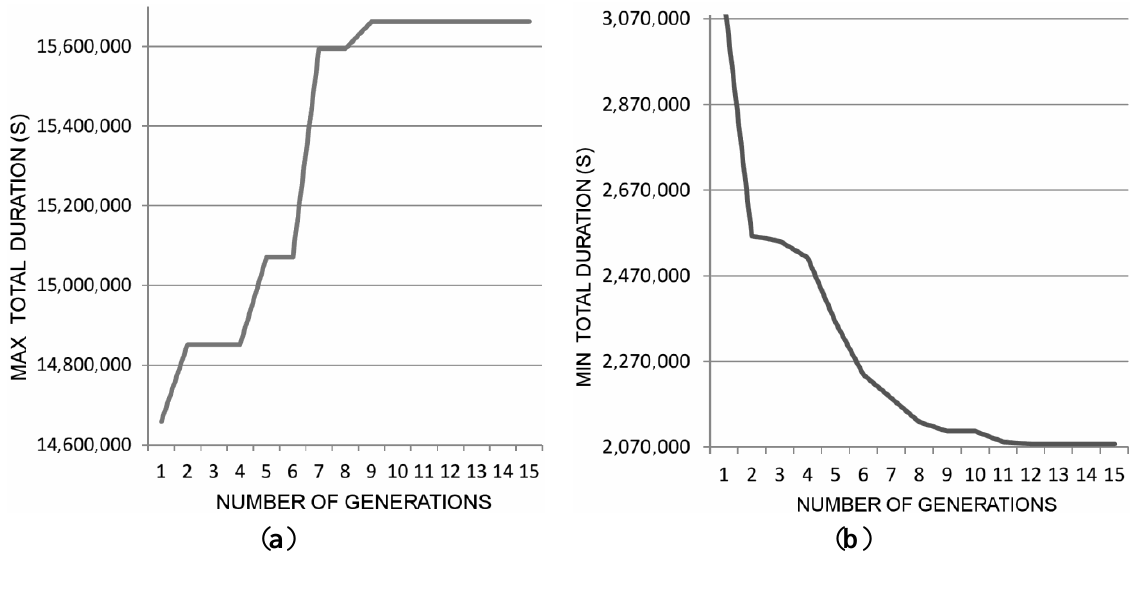
Figure 13. Total duration vs. number of generations for the Shipment